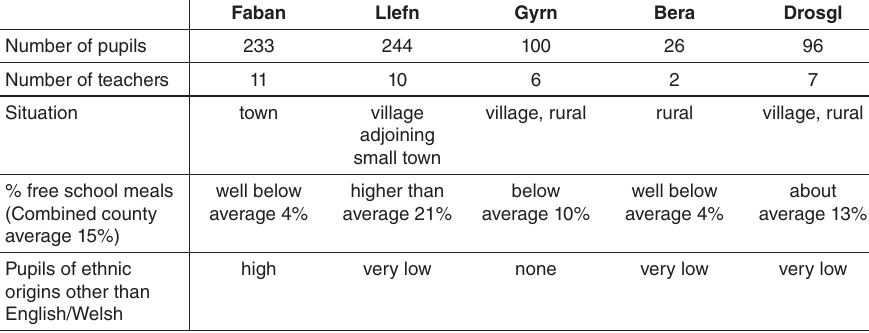
Table 1: Description of the case study schools Faban Llefn Gyrn Bera Drosgl Number of pupils 233 244 100